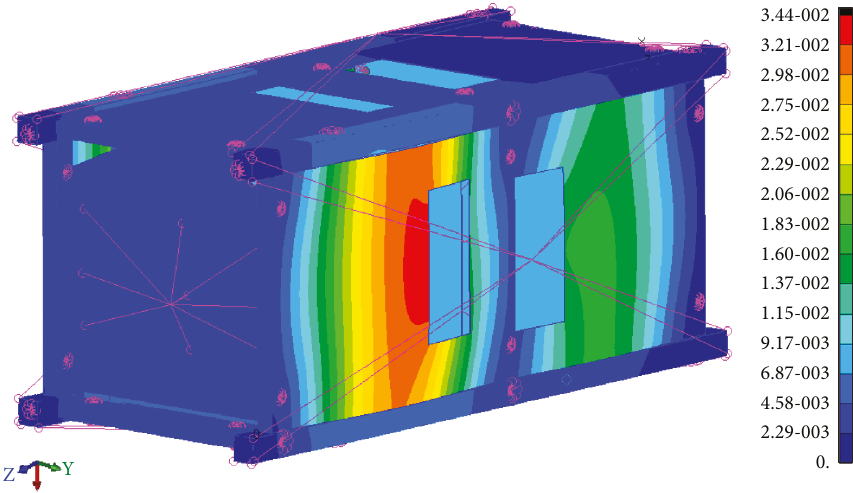
Figure 8: Displacement distribution ( x -axis).